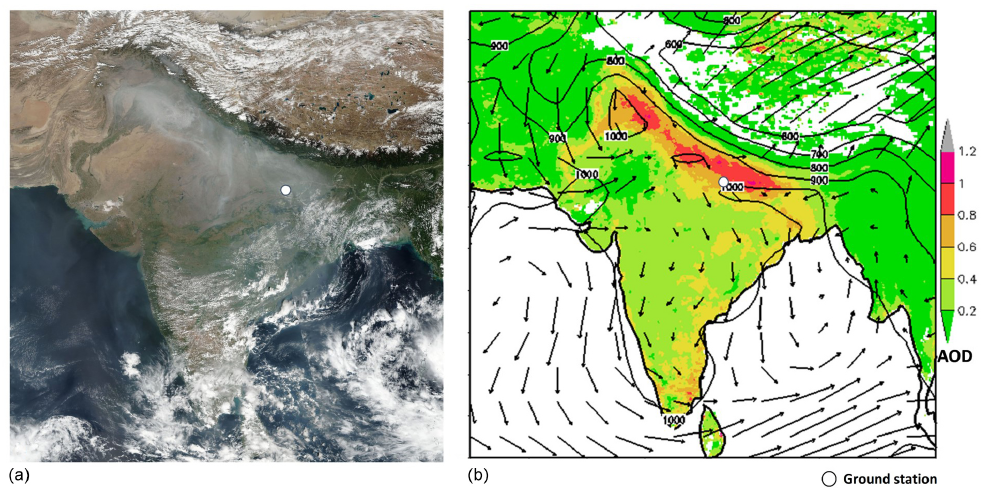
Figure 1. Geographical location of the aerosol ground monitoring station (a) and MODIS aerosol optical depth with NCEP/NCAR composite means of wind vectors during the monitoring period (b)